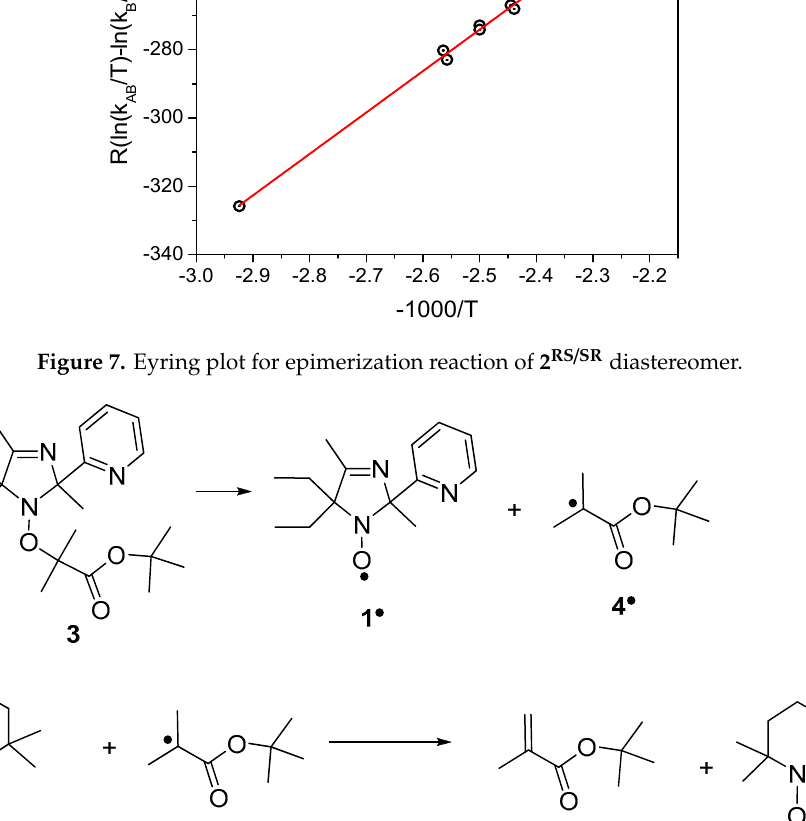
Figure 7. Eyring plot for epimerization reaction of 2 RS/SR